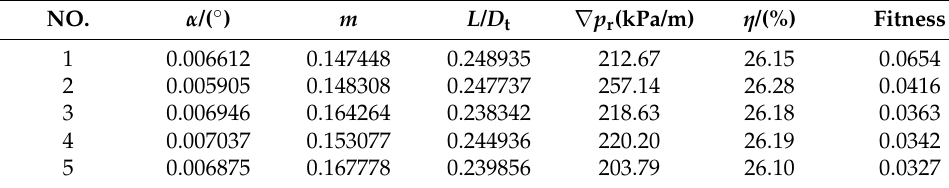
Table 5. Specific information of optimized Pareto solution ( e - η ).